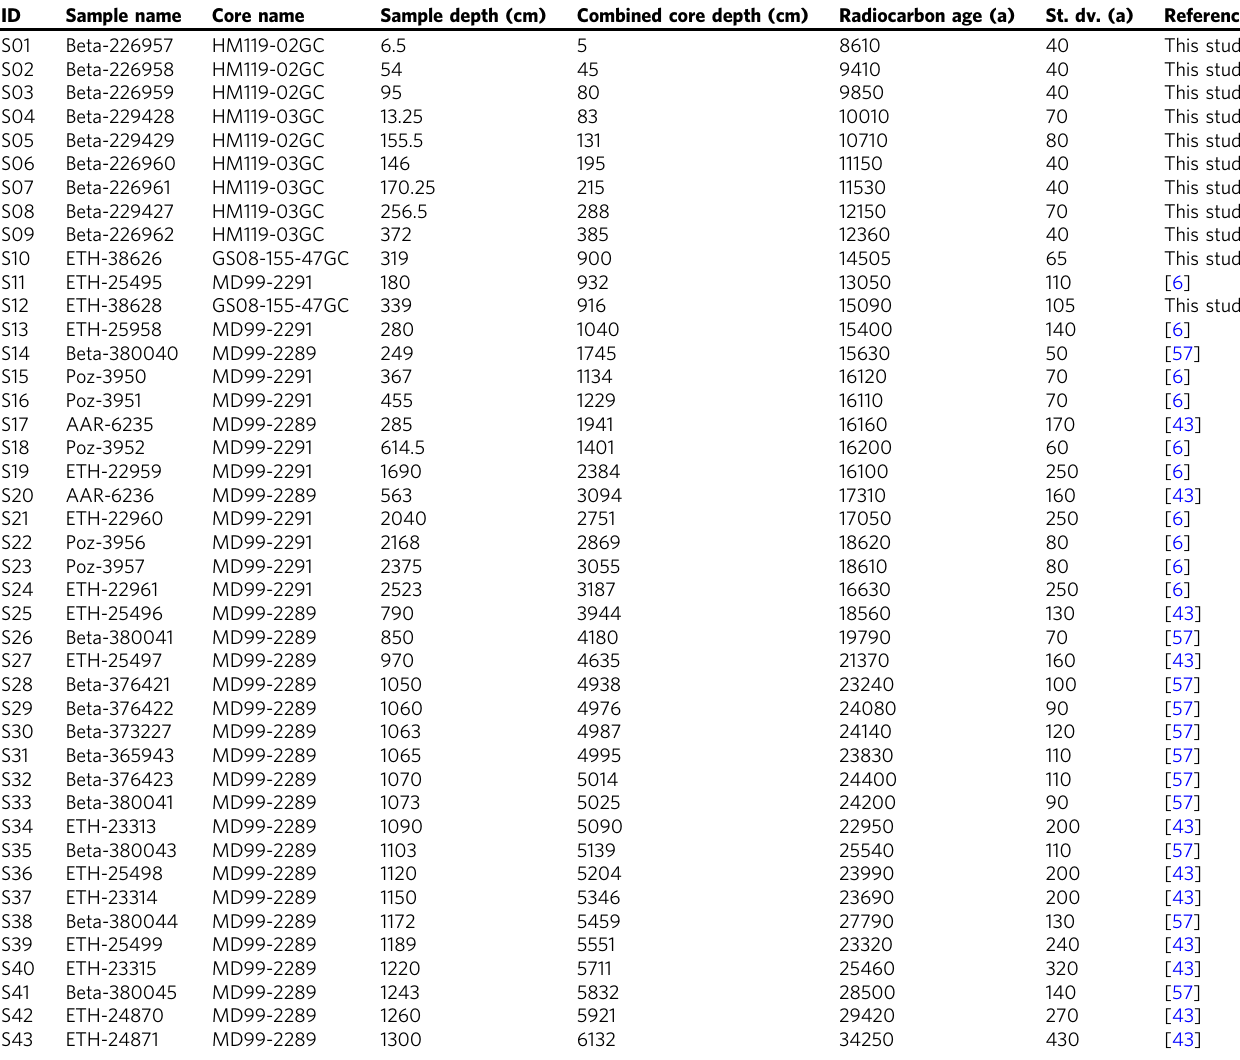
Table 1 Radiocarbon dated samples used for the age-depth model and sedimentation history reconstruction. Radiocarbon ages are not corrected for reservoir effect